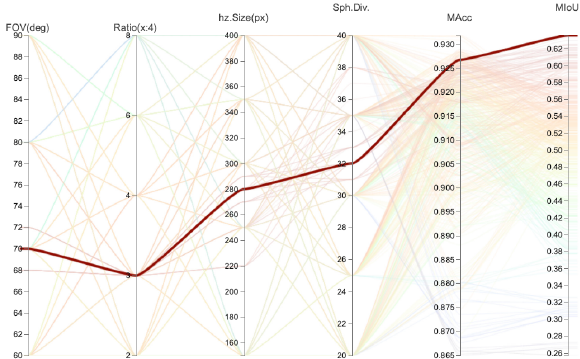
Figure 4. Results of the hyperparameter’s optimisation process (Section 4.2).